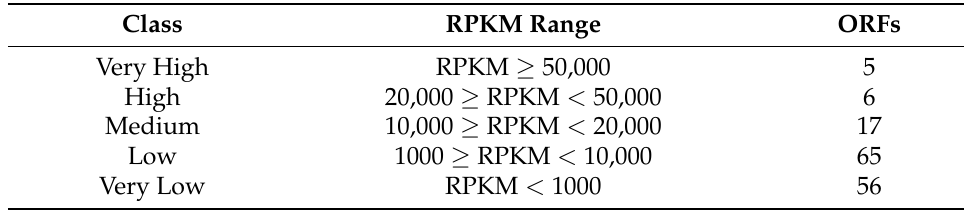
Table 2. RPKM value ranges for Ac MNPV transcript